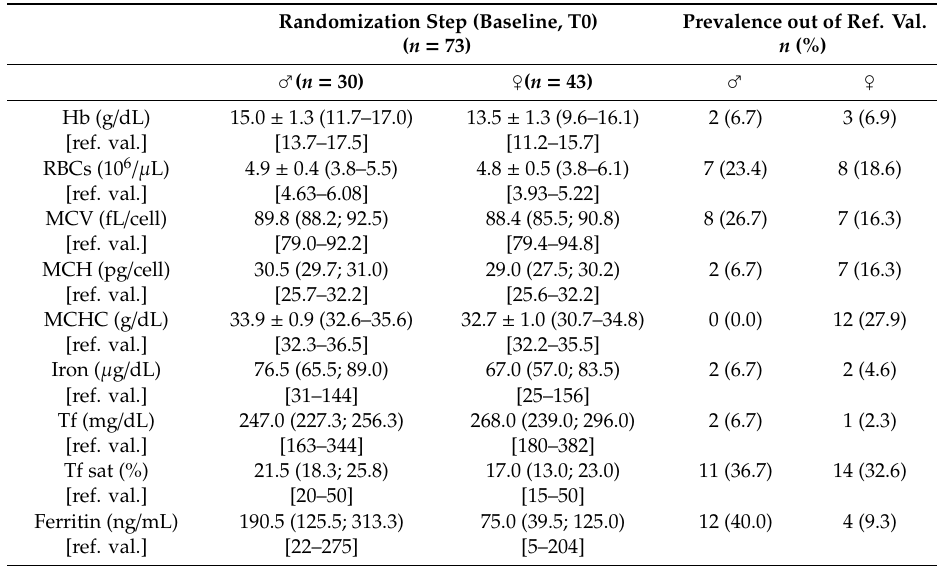
Table 1. Biochemical markers of martial status of study patients who were recruited about 30 days prior to hip or knee replacement during preoperative anesthesia